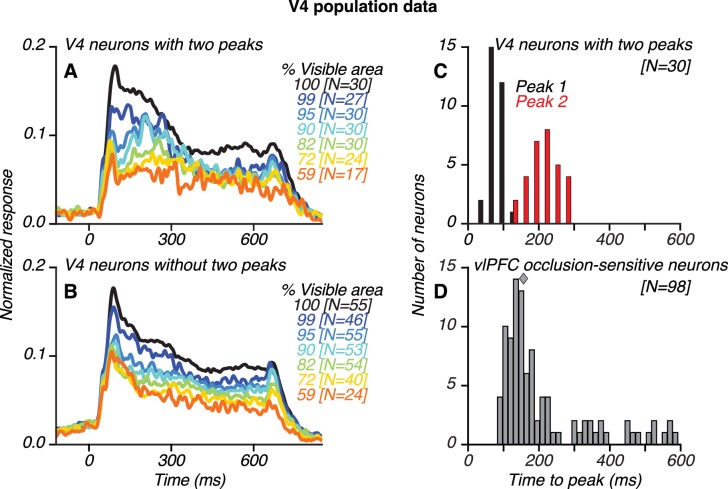
Population results for V4 and vlPFC neurons.(A–B) Population-level, normalized PSTHs for 30/85 V4 neurons that showed two transient response peaks (A) and for V4 neurons without two peaks (B), identified using an ad hoc algorithm (see Materials and methods). The numbers of neurons contributing to each curve are listed in brackets. (C) Distribution of the first (black) and second (red) response peak times for V4 neurons with two peaks. (D) Distribution of the latency of peak responses for occlusion-sensitive vlPFC neurons; median latency was 157 ms (diamond). The first and second response peaks in V4 typically occurred before and after the peak response of vlPFC neurons, respectively. Also see Figure 6—figure supplement 1.